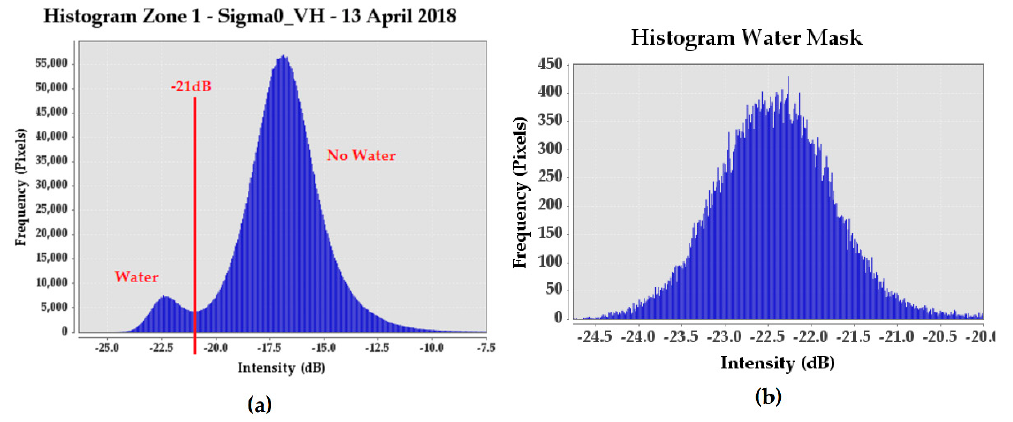
Figure 11. ( a ) Characteristic histogram of zone 1: Novillas–Pradilla de Ebro with VH polarization. ( b ) Representative histogram only for the water zones.